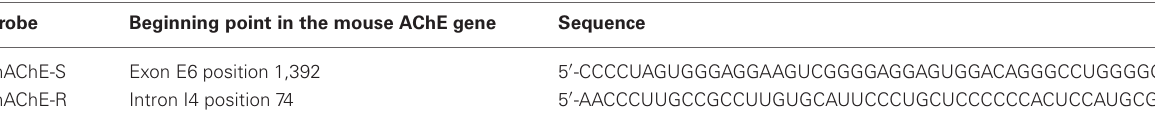
Table 2 | Complementary RNA probes.